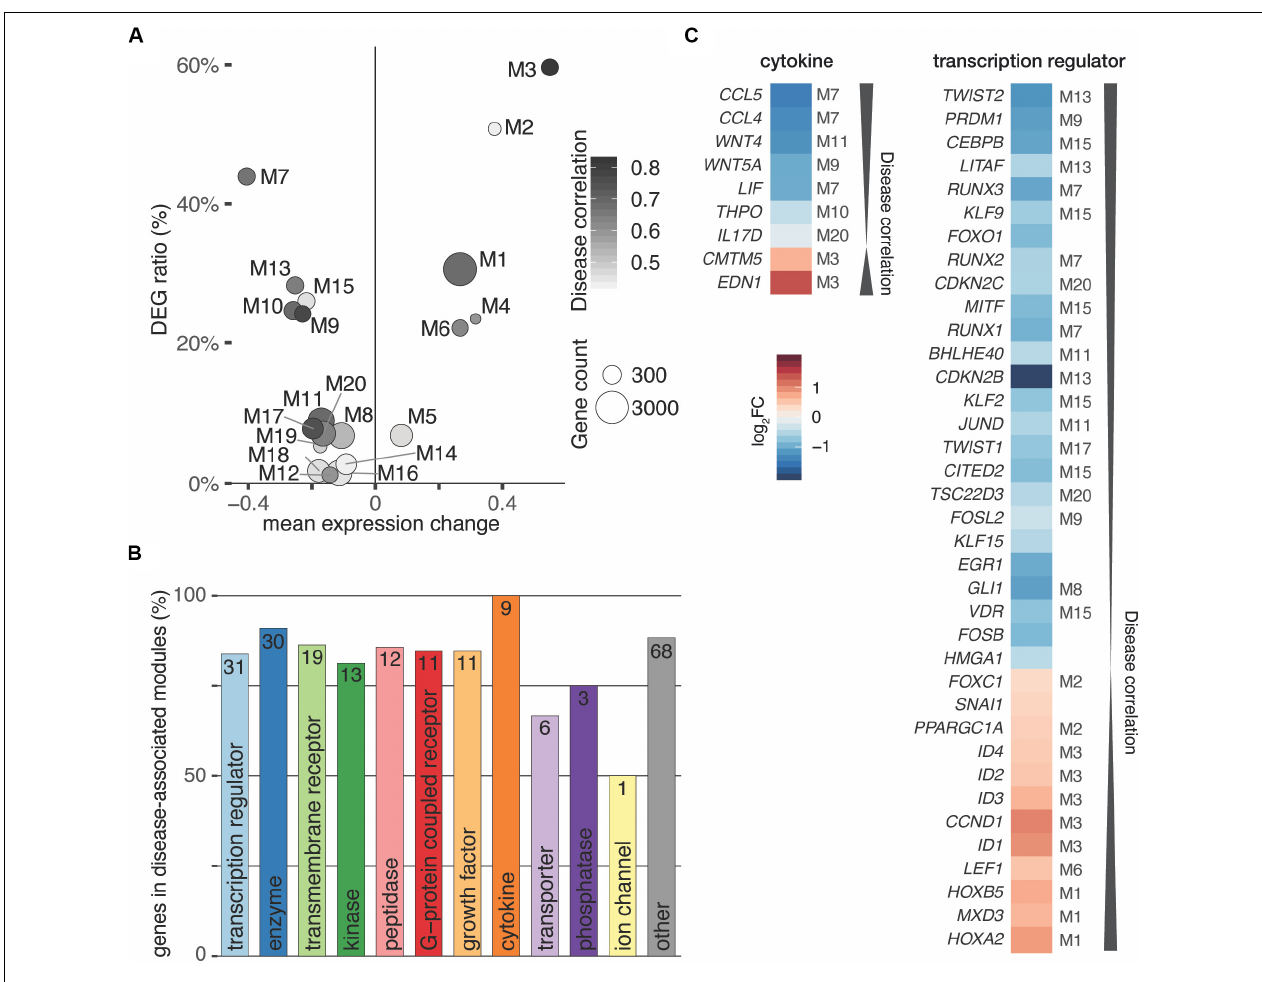
FIGURE 4 | Interactors of TGFB1 reach in all disease-associated co-expression modules. (A) Weighted gene correlation network analysis (WGCNA) identified 35 co-expression modules of which 20 were significantly associated with the disease. (B) Bar diagram depicting the number of TGFB1 interactors in disease-associated modules. Absolute number within bar as well as amount in percent shown on y -axis for each functional type. (C) Cytokines and transcriptional regulators predicted to interact with TGFB1 are in highly disease-associated co-expression modules. Module of interactors indicated for significant modules